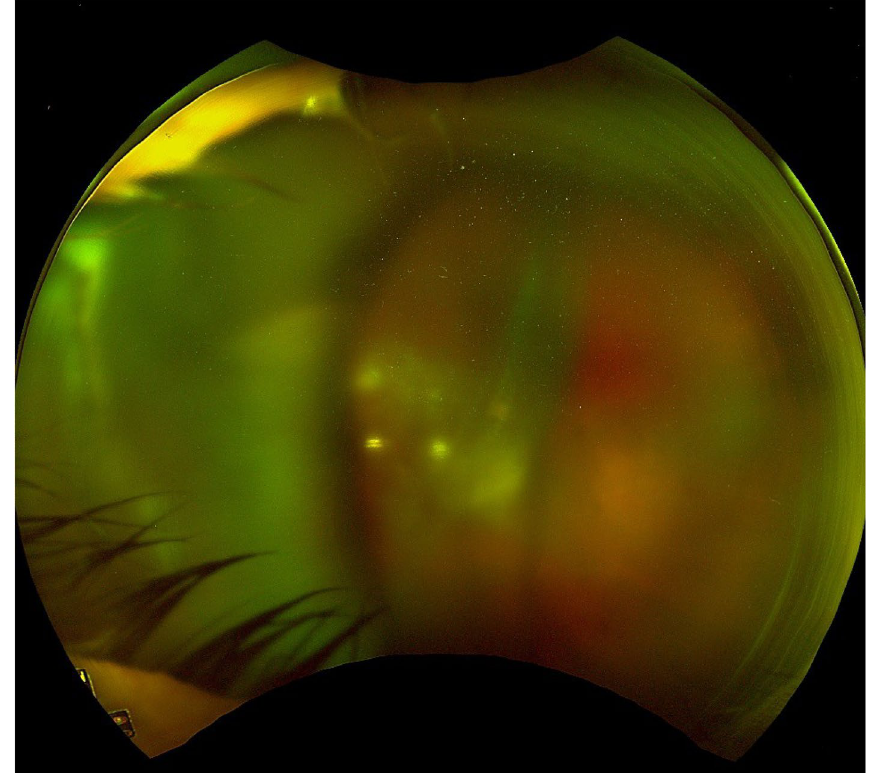
Fig. 1 Optos photo of left eye on day of presentation and